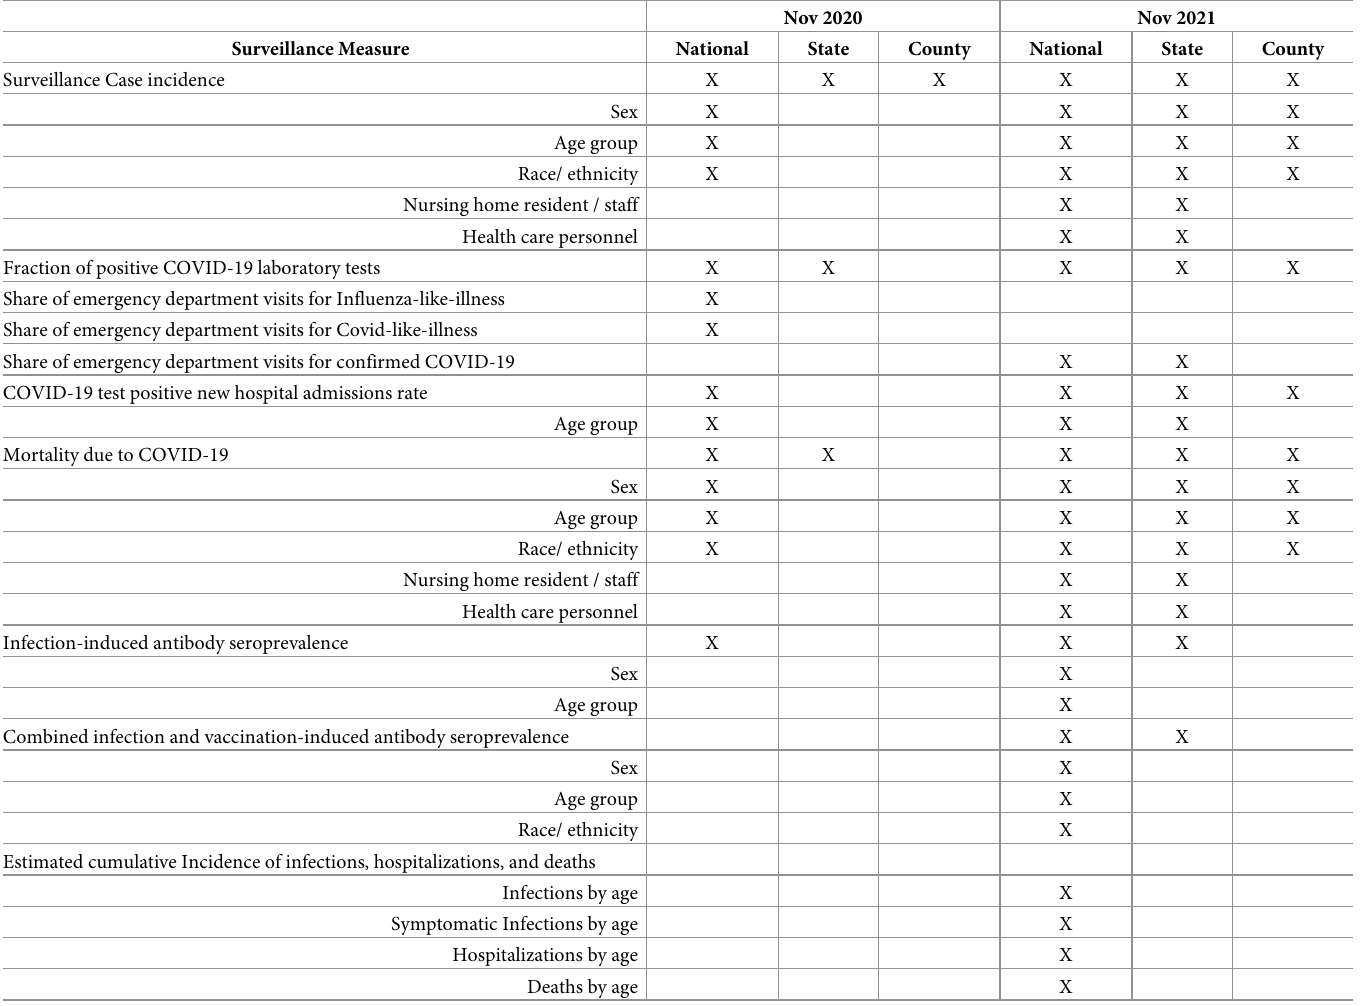
Table 3. Scope of US CDC publicly reported Covid-19 disease surveillance